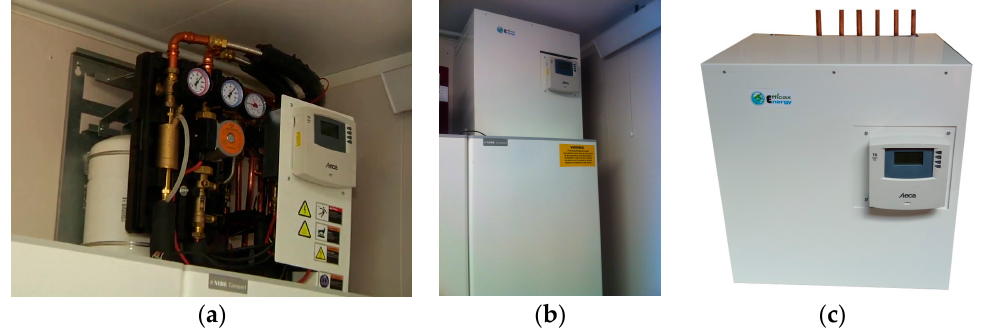
Figure 5. Picture of the prototype: ( a ) without the external cover; ( b ) with the external cover; ( c ) showing the connections to: collector inlet, collector outlet, cold water main, domestic hot water supply to user, auxiliary heater inlet and outlet.